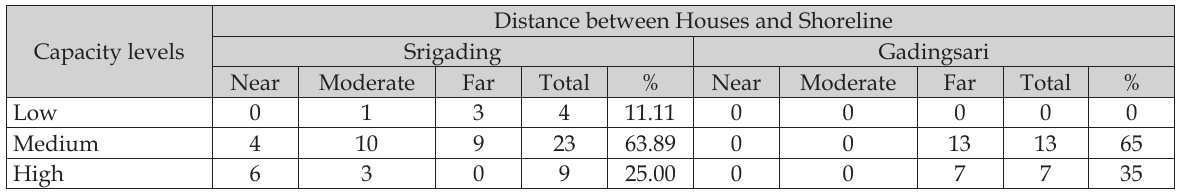
Table 5. Number of respondents in Srigading and Gadingsari based on capacity level and distance between houses and shoreline.